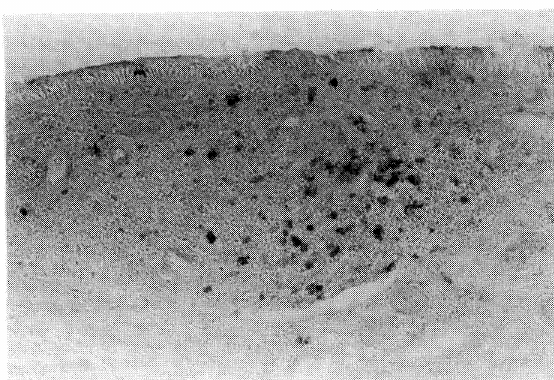
FIG. 1. Levels of serum slL-2R and clinical severity. Elevation of serum slL- 2R level was observed in nasal allergy patients (n 26) compared with normal subjects (n